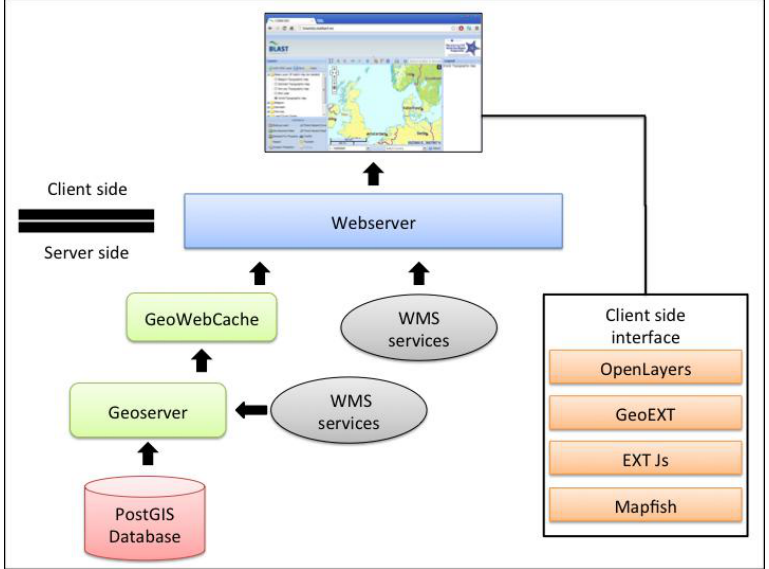
Figure 3. System diagram for the Coastal Indicator System.